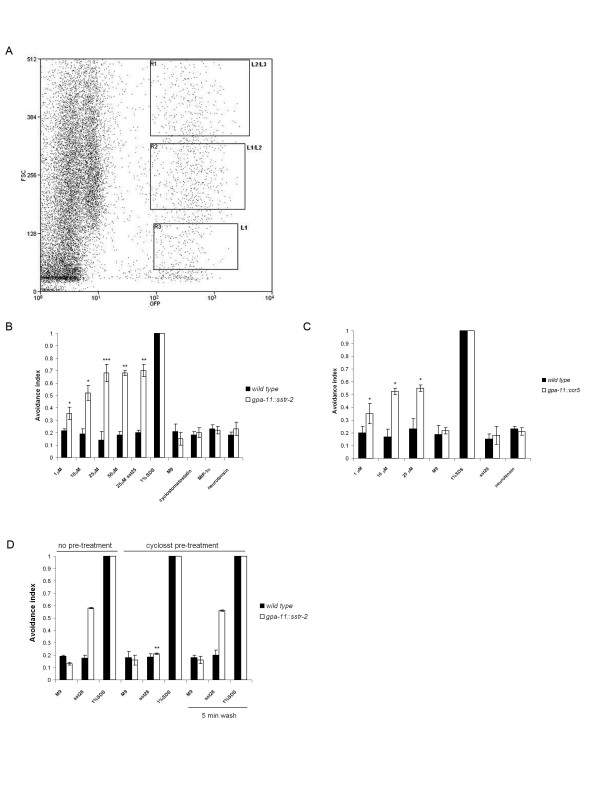
Expression of mouse Sstr2 and human CCR5 in nociceptive neurons in C. elegans generates agonist specific avoidance behaviour. (A) Flow sorting of transgenic nematodes expressing heterologous GPCRs and gut specific GFP marker (elt-2::GFP). Graph shows a plot of forward scatter (size) against GFP fluorescence intensity. GFP-positive animals are sorted into larval stages L1, L2 and L3 according to size with 90% purity and 95% viability (sort gates R1, R2 and R3 respectively). (B) Wild type and Sstr2 transgenic animals were tested with 1–50 μM of SST-28. As controls, the responses to 1% SDS, M9 diluent, the unrelated neuropeptides, neurotensin and MIP-1α were determined. Sstr2 transgenic animals did not avoid 25 μM cyclosomatostatin. Both strains display a normal avoidance response to 1% SDS. Asterisks indicate a statistically significant difference between wild type and Sstr2 transgenic animals. (C) Avoidance responses of wild type and CCR5 transgenic animals to various concentrations of MIP-1α, M9 diluent, 1% SDS and 25 μM SST-28. Error bars denote the standard error of the mean. Asterisks indicate a statistically significant difference between wild type and CCR5 transgenic animals. (D) Animals were either directly tested for their response to M9, SST-28 or 1% SDS or pre-incubated with 25 μM cyclosomatostatin (denoted cyclosst in figure) for 3 minutes before the assays. Pre-treatment with 25 μM cyclosomatostatin abolished the avoidance response of Sstr2 transgenic animals to 25 μM SST-28. Avoidance responses can be recovered by an additional 5 minutes wash to remove cyclosomatostatin. Asterisks indicate a statistically significant difference between cyclosomatostatin treated and untreated transgenic animals. In all panels, each data point represents an average of at least five independent assays for wild-type and each respective strain. Error bars denote the standard error of the mean. (*p ≤ 0.05, **p ≤ 0.01, ***p ≤ 0.005). Avoidance index = number of worms behind barrier/total number of worms